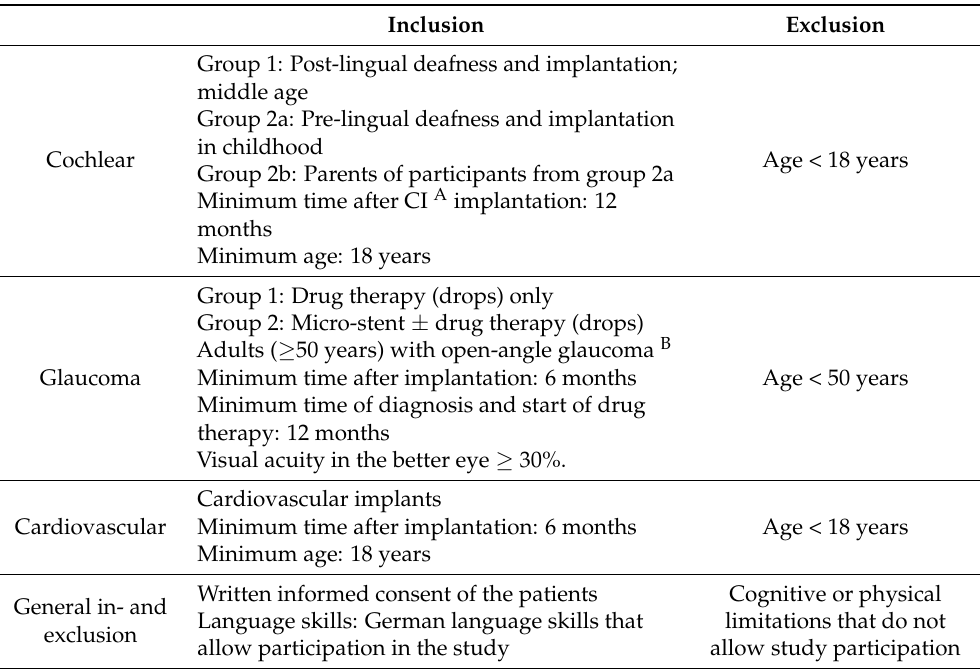
Table 1. Eligibility criteria for group discussions and diary